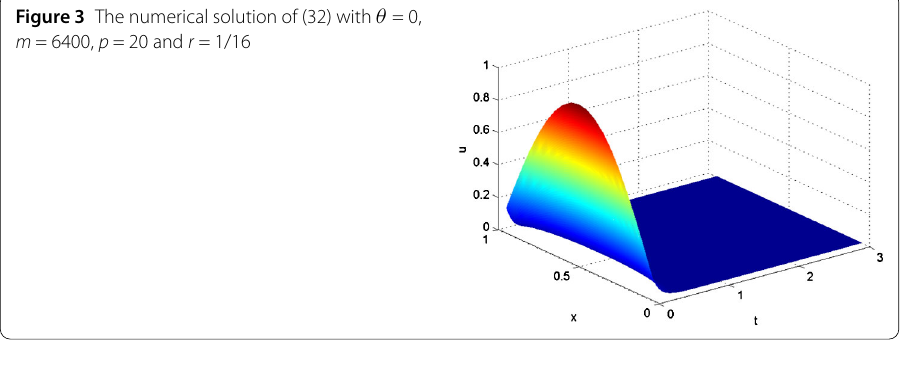
Figure 4 The numerical solution of (32) with θ = 0.5, m = 128, p = 16 and r = 2